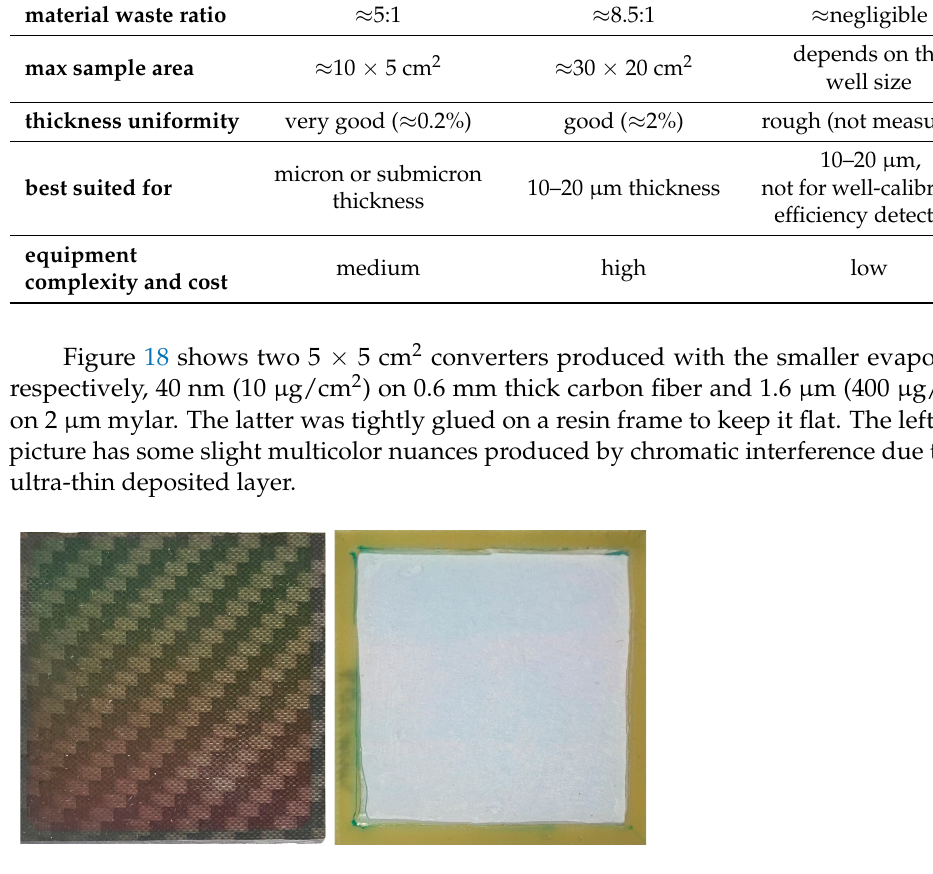
Figure 18. Two 5 × 5 cm 2 6 LiF converters produced with the smaller evaporator. Left: 40 nm (10 µg/cm 2 ) on 0.6 mm carbon fiber. Right: 1.6 µm (400 µg/cm 2 ) on 2 µm mylar.